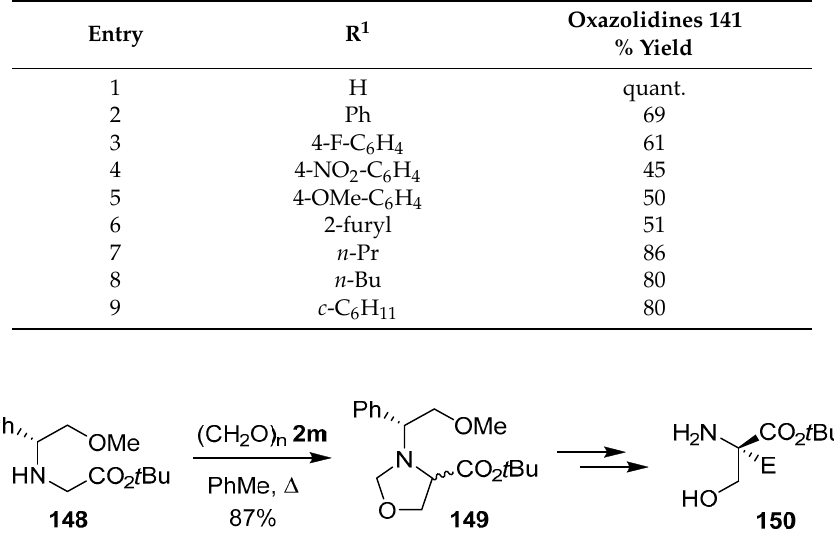
Table 20. Cycloaddition of azomethine ylide 140 to aldehydes 2 (Scheme